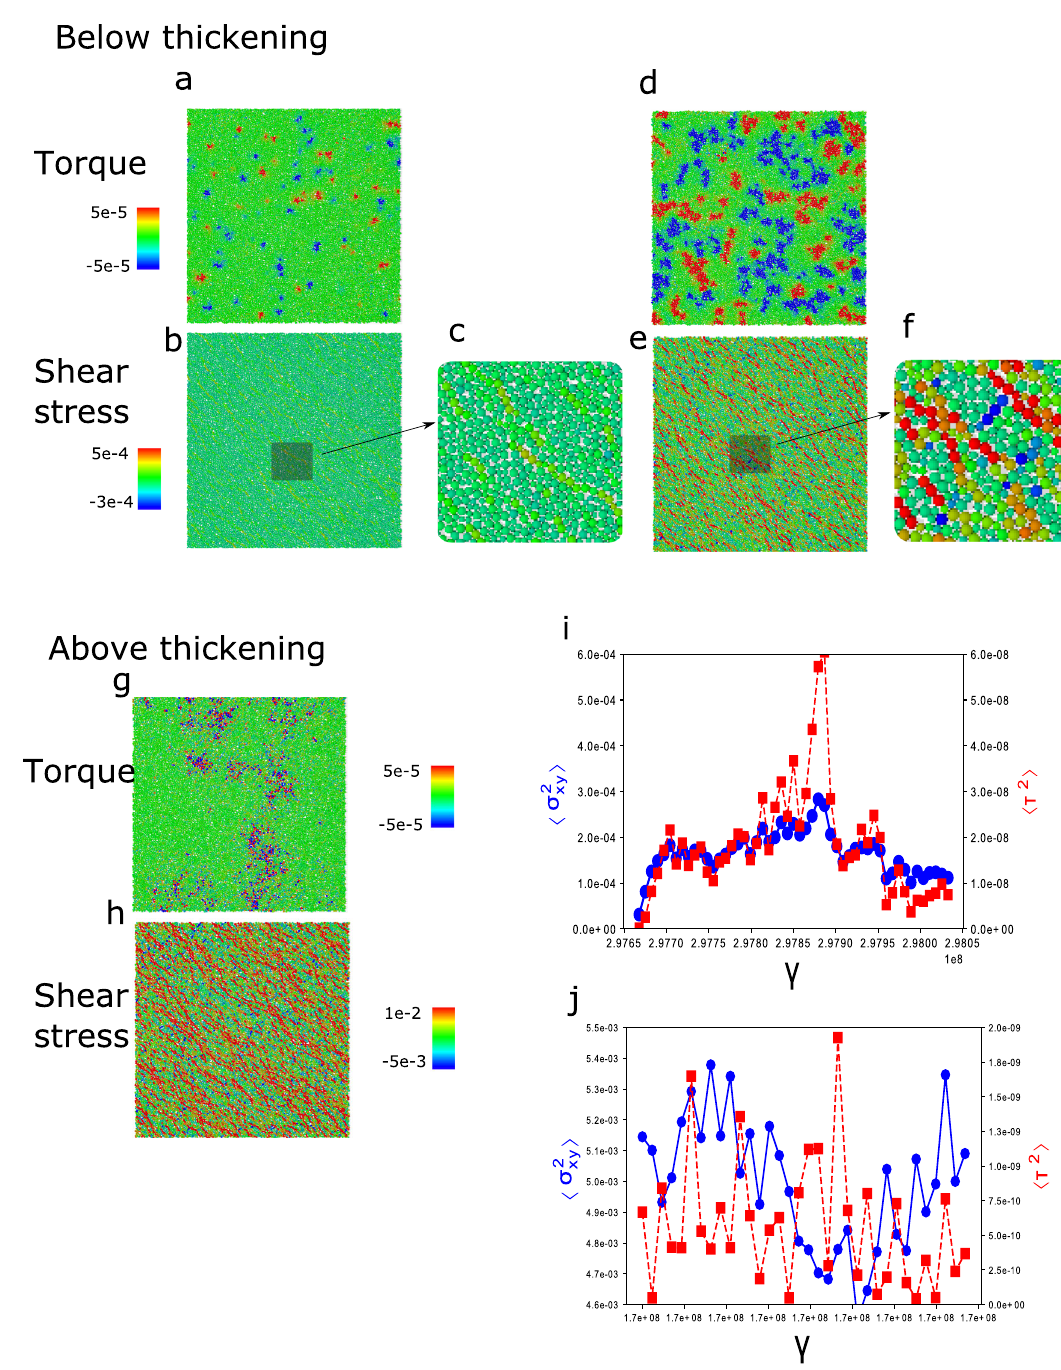
Fig. 5 Like-torque clusters and rheology across the discontinuous shear thickening transition. A snapshot of the system is depicted by two different measures: panel ( a ) total torque per particle and panel ( b ) total shear stress per particle. The global shear rate is equal to _ γ ¼ 4 : 467 ´ 10 (cid:2) 6 . Small clusters of very large positive (red) and negative (blue) torque particles can be seen; at the same time, the stress in the system is homogeneous. This phenomenon can be better seen in a close-up in panel ( c ). In panel ( d ), a con fi guration of the system with a strain difference of three particle diameter with respect to panel ( a ) is given; the global shear rate is not changed. In this panel, the instability has set in, and the like-torque clusters are grown. Panel ( e ) shows that the stress becomes highly heterogeneous. In panel ( f ), a close-up is given. Stress-bearing chains of large negative stress (blue) can be seen along the dilation direction, while large positive chains (red) elongate along the compression direction. The population of like-torque clusters and the stress-bearing chains are qualitatively correlated. In panels ( g , h ), we show that such a correlation does not exist above thickening for _ γ ¼ 1 : 122 ´ 10 (cid:2) 5 . Panel ( i ) The second moments of stress per particle (blue circles) and torque per particle (red squares) are depicted versus the strain. This panel shows that fl uctuations in the stress and torque are correlated below thickening, at _ γ ¼ 4 : 467 ´ 10 (cid:2) 6 , supporting the hypothesis of a qualitative correlation between the population of like-torque clusters and the stress-bearing chains. By correlation, we mean that the stress and torque change proportionately as a function of strain. Such a correlation cannot be seen above thickening (panel ( j )). Panels (i, f) show instantaneous averaging over particles and error bars are smaller than symbol